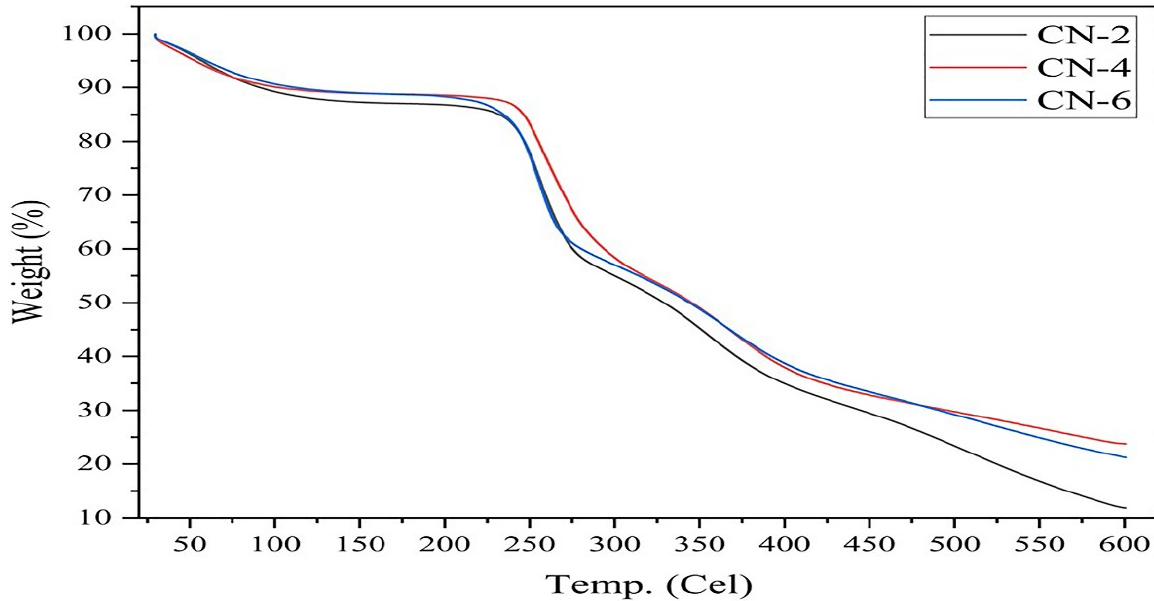
Figure 7. Thermogravimetric (TG) curve of jute CNC samples of CN-2, CN-4, and